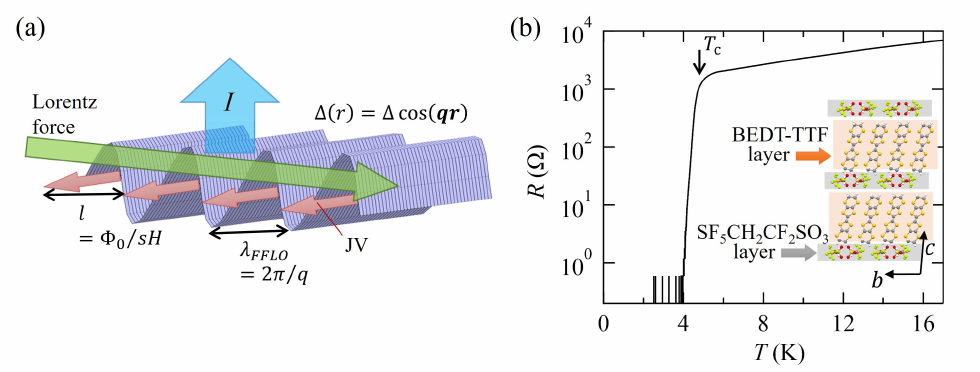
Figure 1. ( a ) Schematic illustration of the order parameter oscillation ∆ ( r ) for a single q case in a FFLO phase and JV lattice in a layered superconductor. The JVs are easily driven by the Lorentz force in an interlayer current I , leading to nonzero interlayer resistance even in the superconducting phase. ( b ) Temperature dependence of the interlayer resistance of the β (cid:48)(cid:48) -SF 5 salt. The onset of the superconducting transition can be defined as T c ≈ 4.8 K, consistent with the specific heat measurement [23]. Inset: crystal structure of β (cid:48)(cid:48) -SF 5